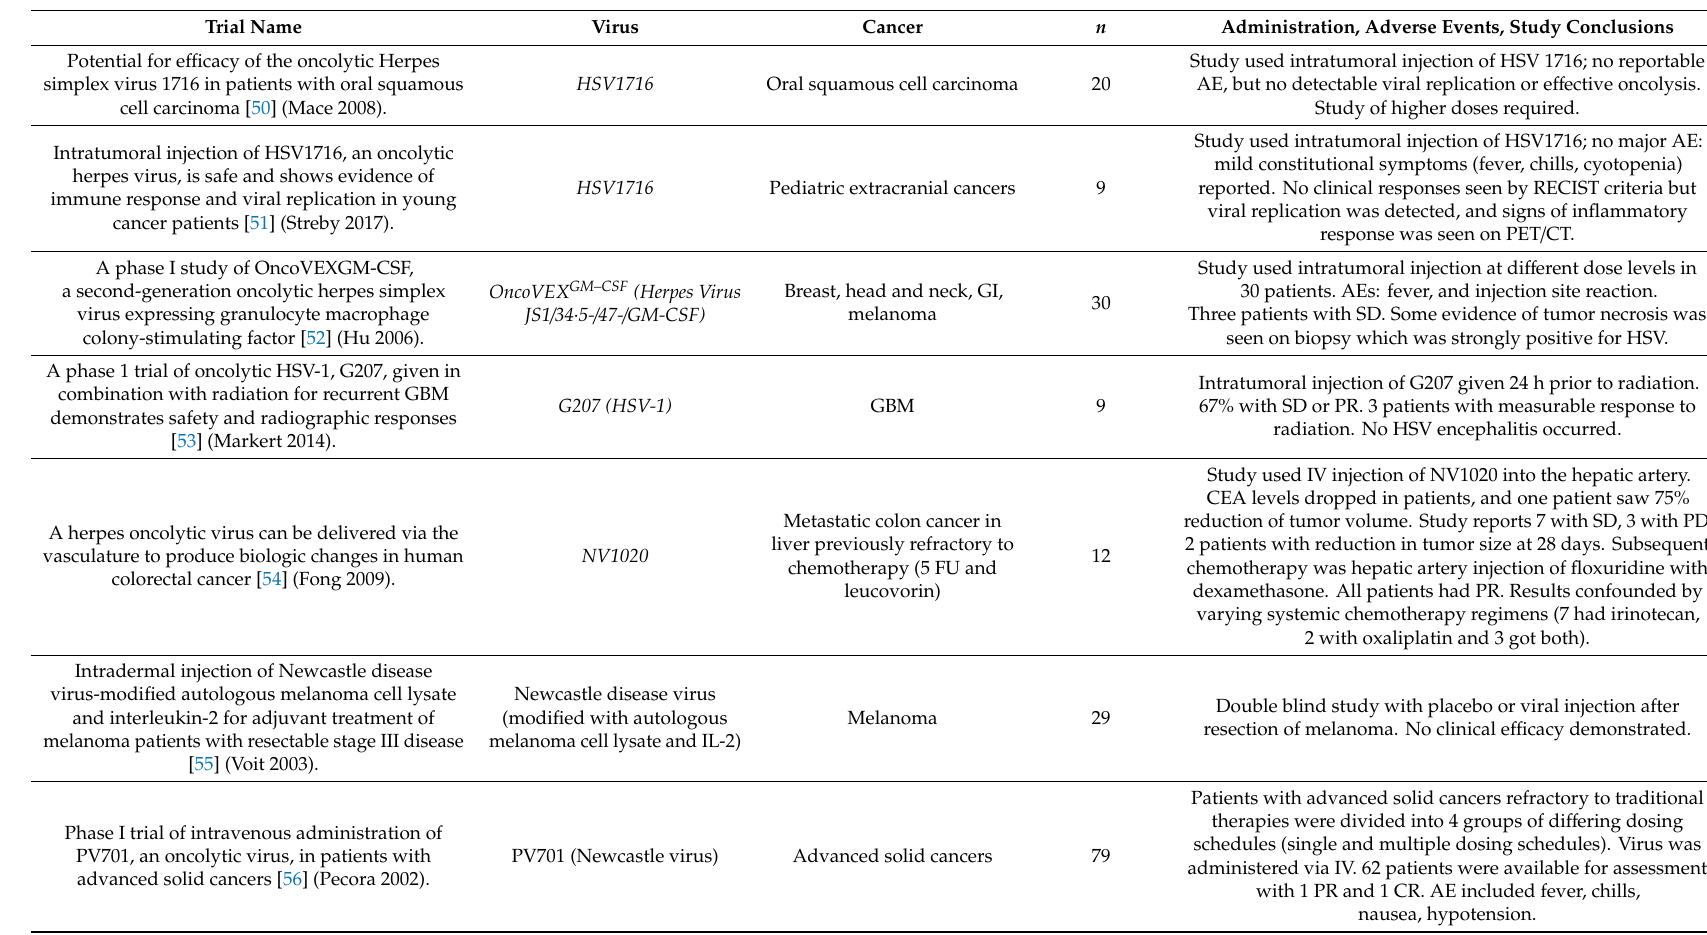
Table 2. Summary of oncolytic virus use in phase I clinical